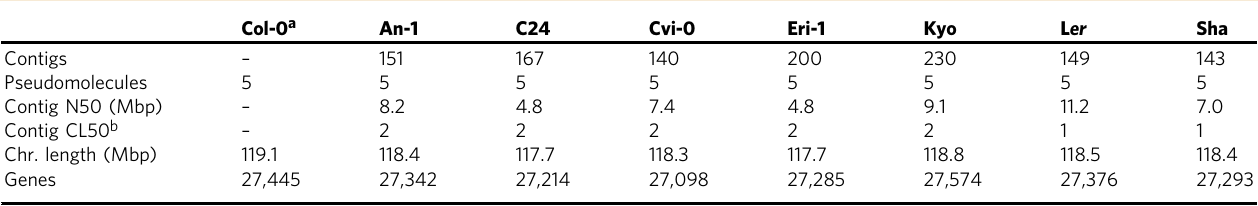
Fig. 1 Chromosome-level genome assemblies of seven A. thaliana accessions. The light gray bars outline each of the chromosomes, whereas the dark gray inlays show the extent of each of the pericentromeric regions. The contig arrangements of the chromosome assemblies is shown in green for contigs > 1 Mb and dark grey for contigs < 1 Mb. The location of centromeric tandem repeat arrays and rDNA clusters within the assemblies are marked by yellow and blue boxes above each of the chromosomes. Source Data are provided as a Source Data fi le. Table 1 Genome assembly and annotation of seven A. thaliana